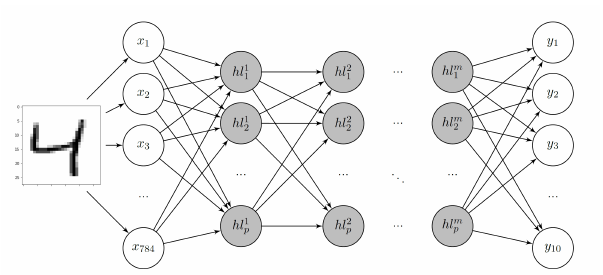
Figure 4. Artificial neural network architecture for the MNIST dataset classification. The input layer consists of 784 nodes ( x i ), one for each of the 28 × 28 pixels of the input. The output layer consists of 10 nodes ( y i ), one for each class label. There can be several m hidden layers ( hl j number of perceptrons units ( p ). The ANN is fully